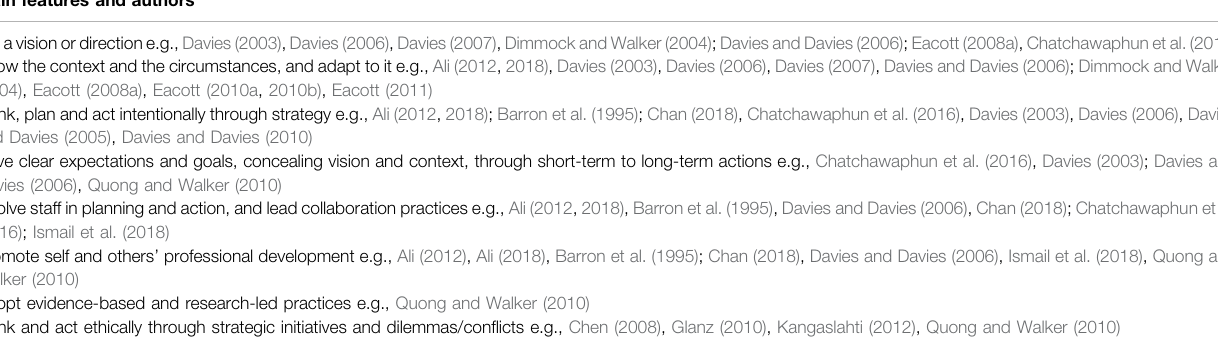
TABLE 3 | Strategic leadership: Main